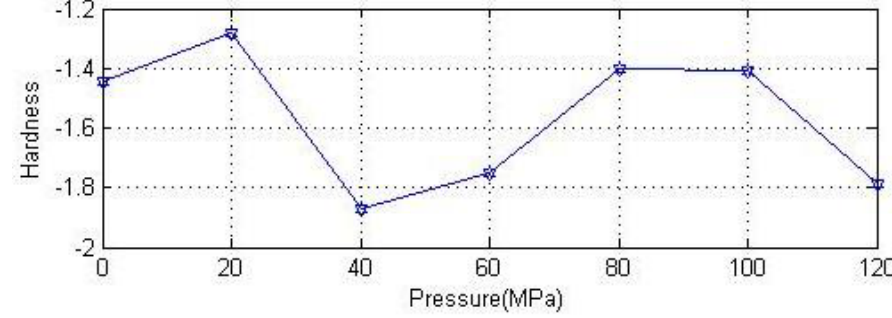
Figure 7. Relation of the hardness of anhydrite crystal with pressure.